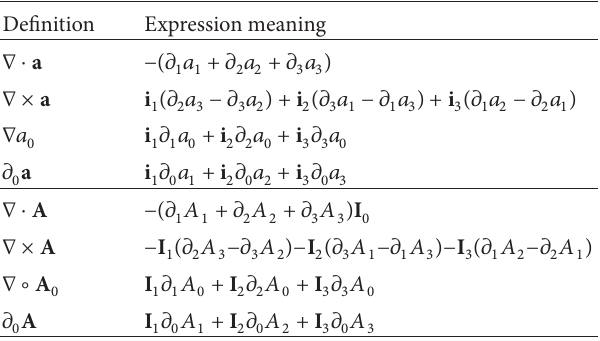
Table 2: The multiplication of the operator and octonion physics